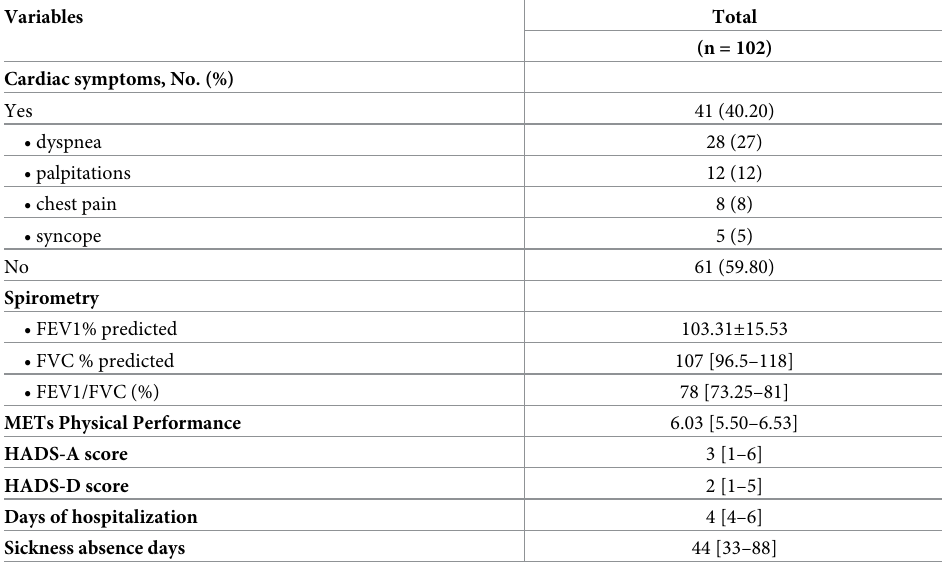
Sickness absence days 44 [33–88] Data are expressed as mean ± standard deviation or median [interquartile ranges: 25th-75th percentile] or number of subjects (%). FEV1, forced expiratory volume in 1 second; FVC, forced vital capacity; HADS-A score: score of anxiety subscale of the Hospital Anxiety and Depression Scale; HADS-D score: score of depression subscale of the Hospital Anxiety and Depression Scale; MET: metabolic